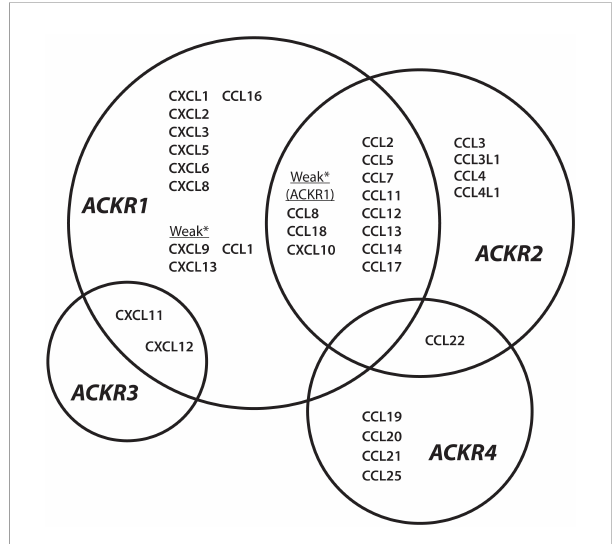
FIGURE 1 ACKR1-4 chemokine interaction network Chemokine ligands